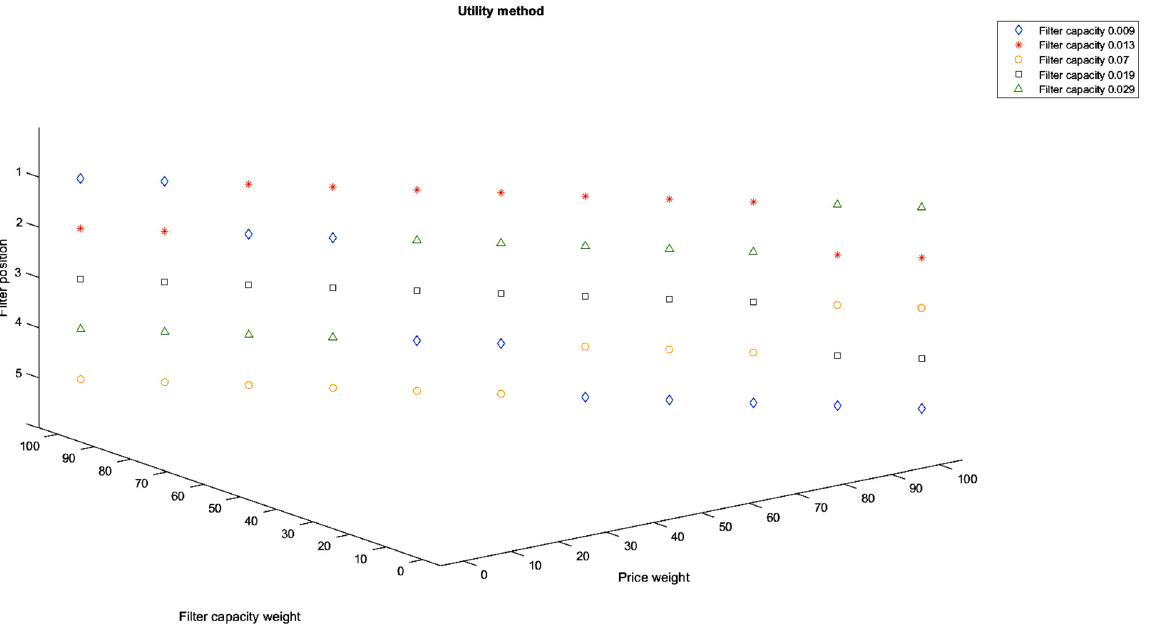
Figure 7. Estimated values using a model with a polynomial regressions and correlation models.